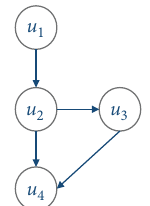
Figure 2: User-user relationship graph.